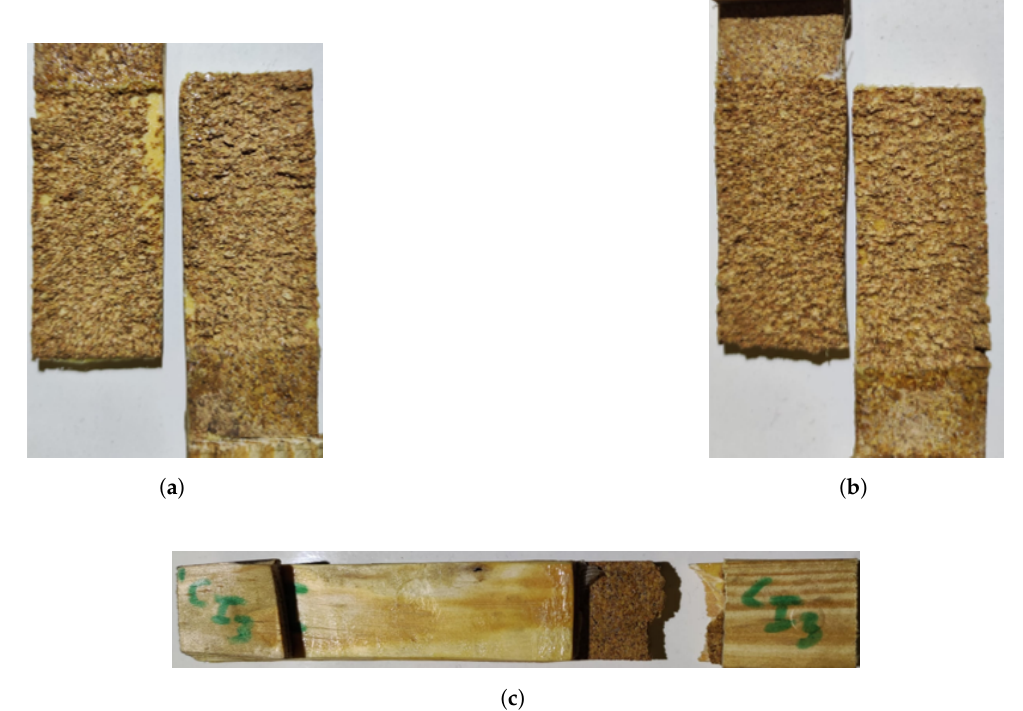
Figure 21. Failure mechanisms at different cross-head rates for WC joints. ( a ) High cross-head rate (6 m/min). ( b ) Impact; cohesive failure in the cork (60 m/min). ( c ) Impact; substrate failure (60 m/min).